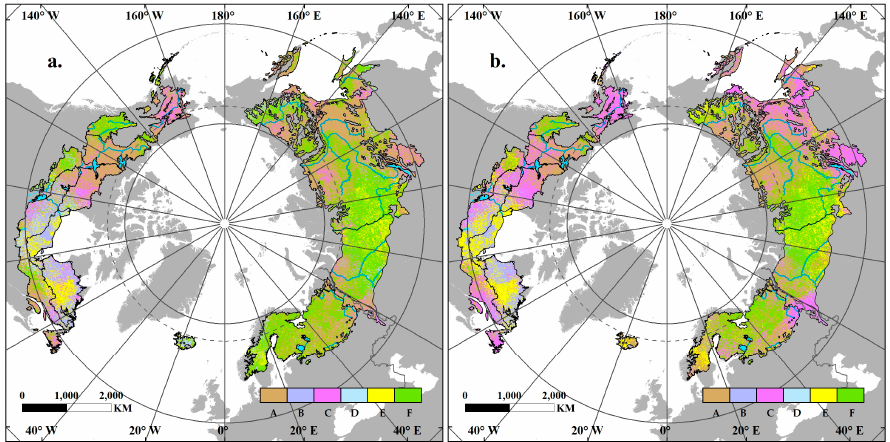
Figure 7. Diurnal temperature changes in the boreal forest from 2001 to 2017 during preseason: ( a ) Diurnal temperature changes during the TMAX preseason and ( b ) during the TMIN preseason. The letters in the legend represent the six possible cases: A) The warming rate of TMAX is faster than TMIN; B) the cooling rate of TMAX is slower than TMIN; C) TMAX warming and TMIN cooling; D) TMAX cooling and TMIN warming; E) the cooling rate of TMAX is faster than TMIN; and F) the warming rate of TMAX is slower than